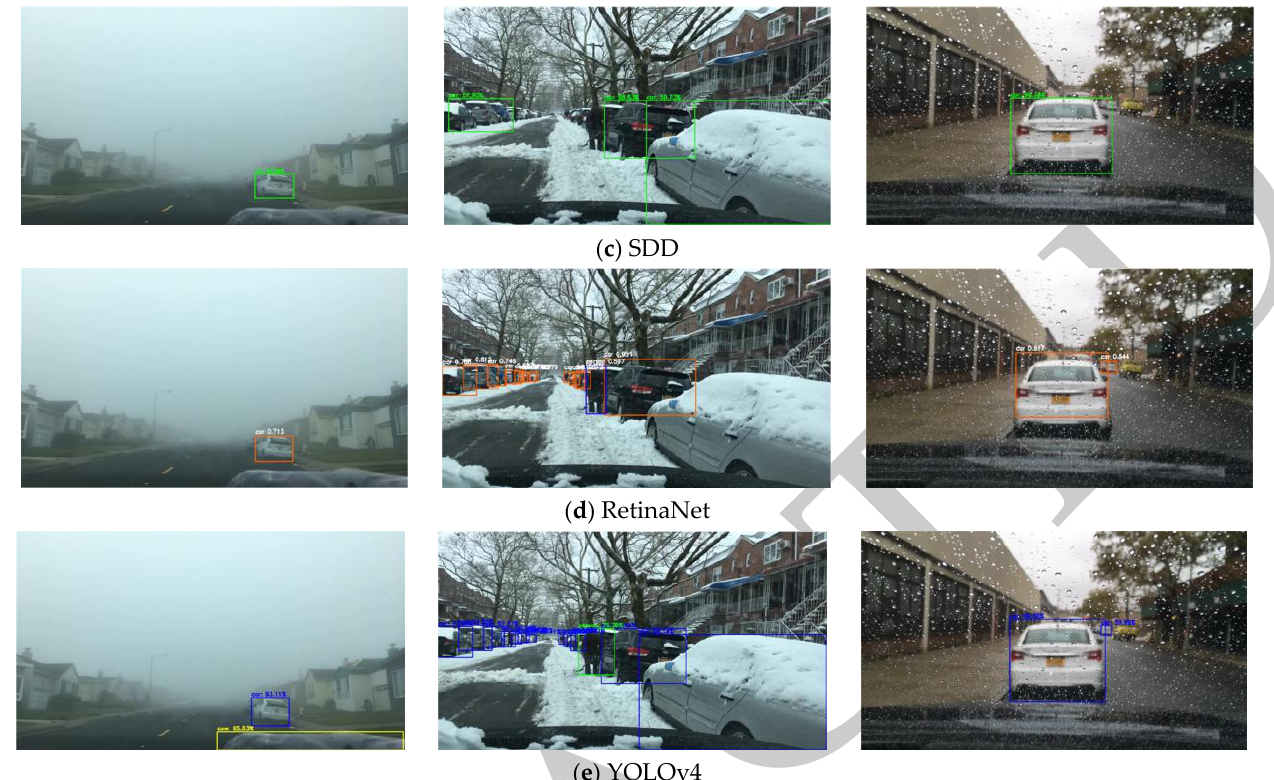
Figure 14. Performance of five deep learning models in different road environmental conditions (from left to right columns: foggy, snowy, and rainy). Table 7. The generalization ability of object detection models on the BDD100K dataset.